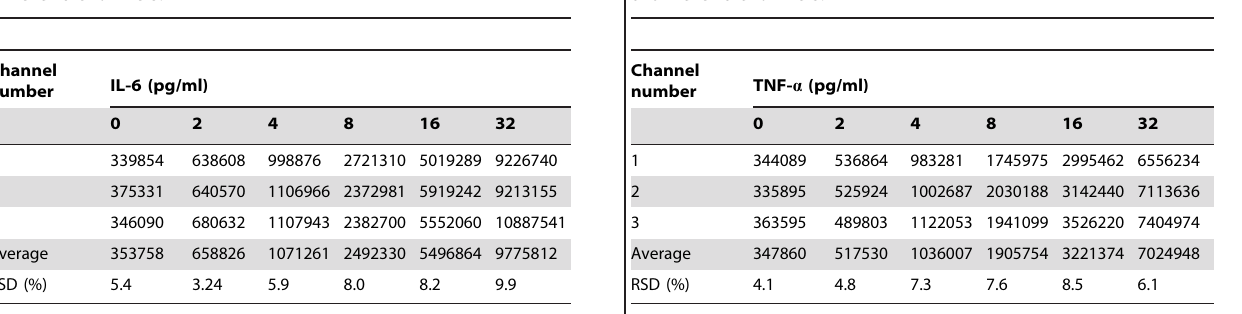
Table 3. Reproducibility of luminescence intensity of IL-6 in 3 different channels.